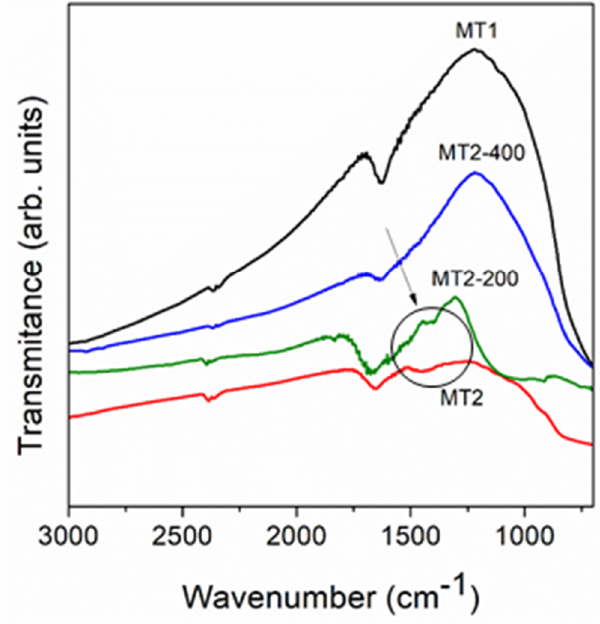
Figure 8. Fourier transform infrared spectroscopy (FTIR) of material (MT1) and all MT2 samples.